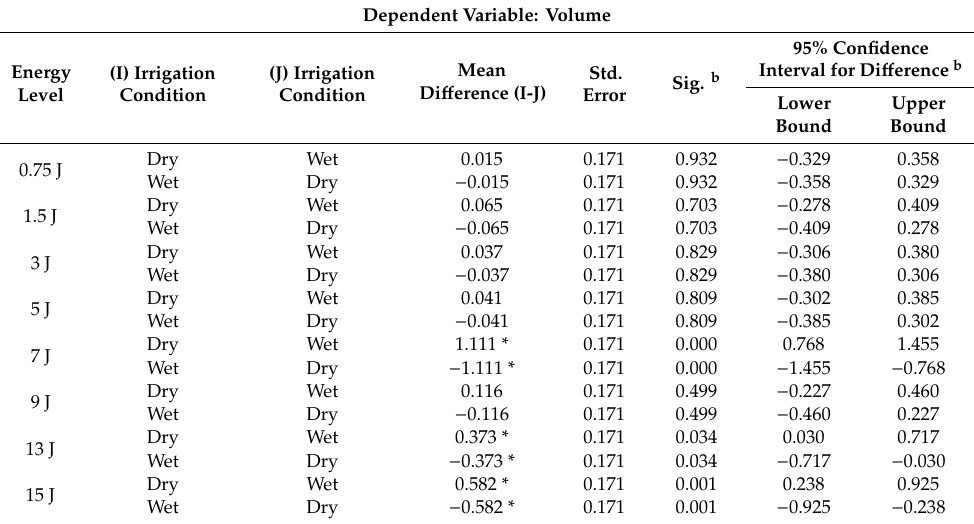
Table A3. Bonferroni-corrected post hoc tests (Irrigation Condition * Energy